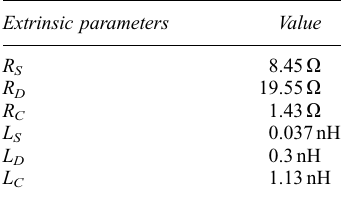
TABLE I Extrinsic Elements of RSTTs.